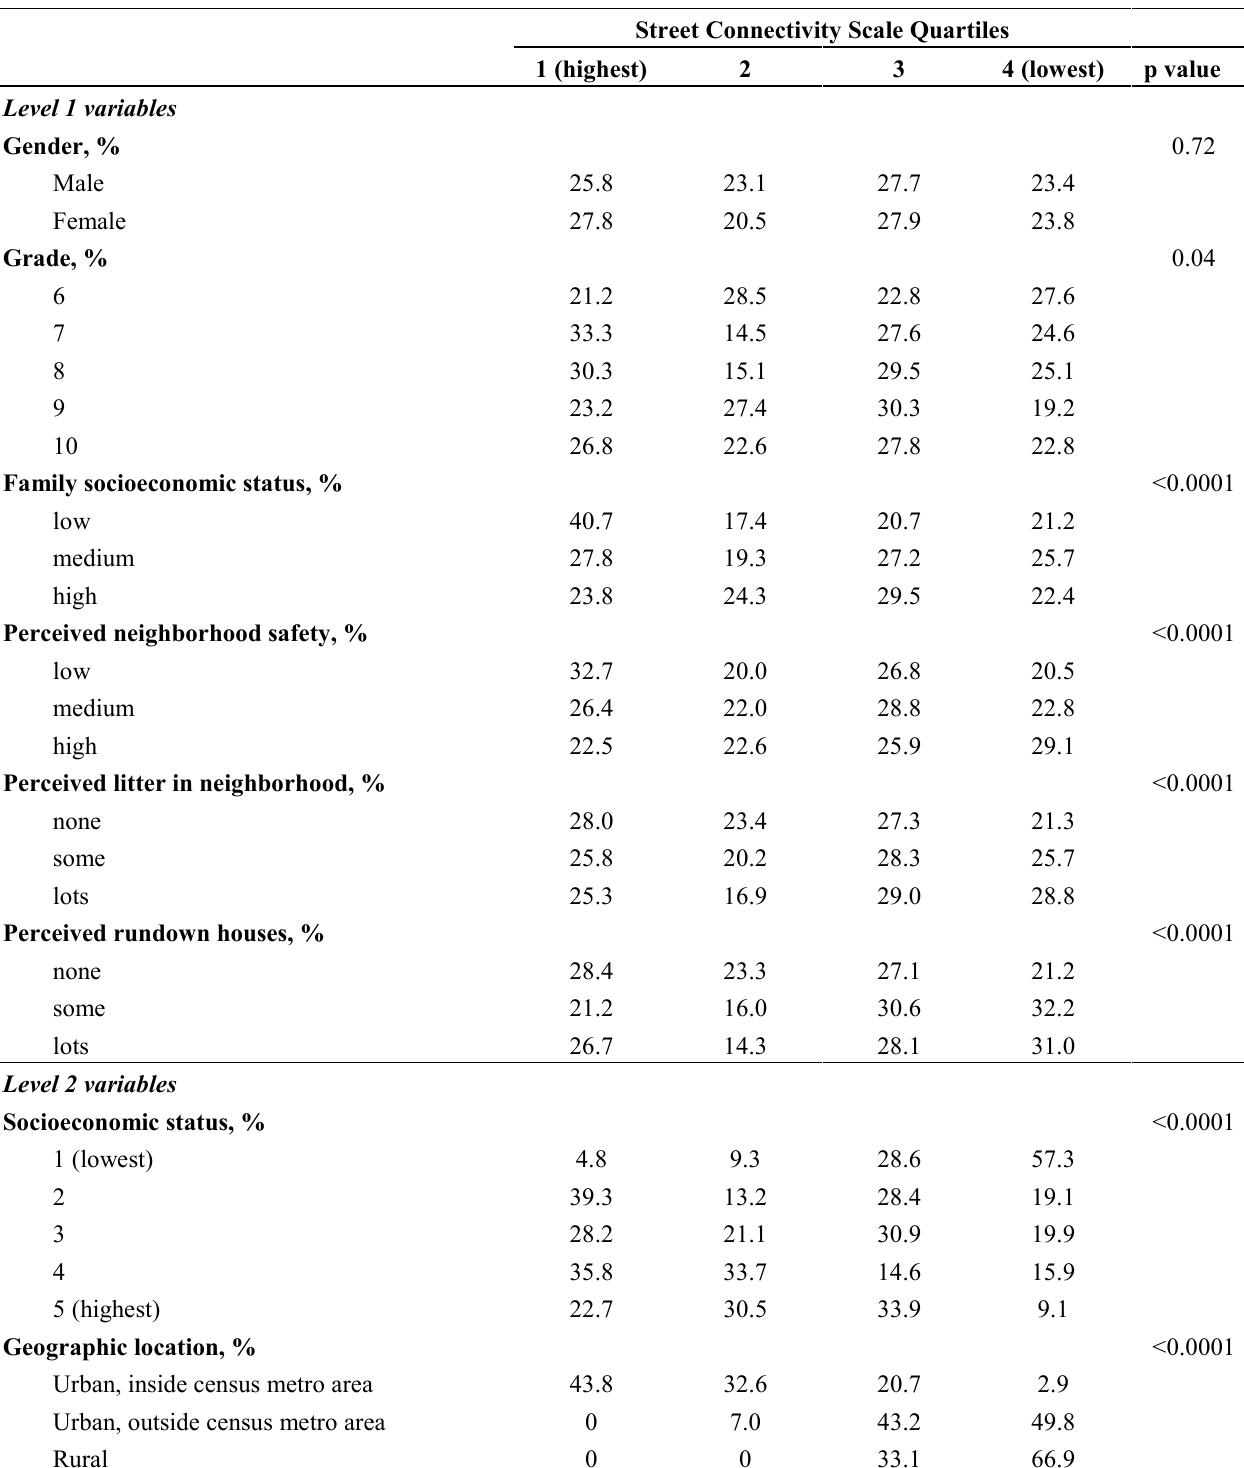
Table 1. Descriptive characteristics of the student sample and neighborhood environment (n =